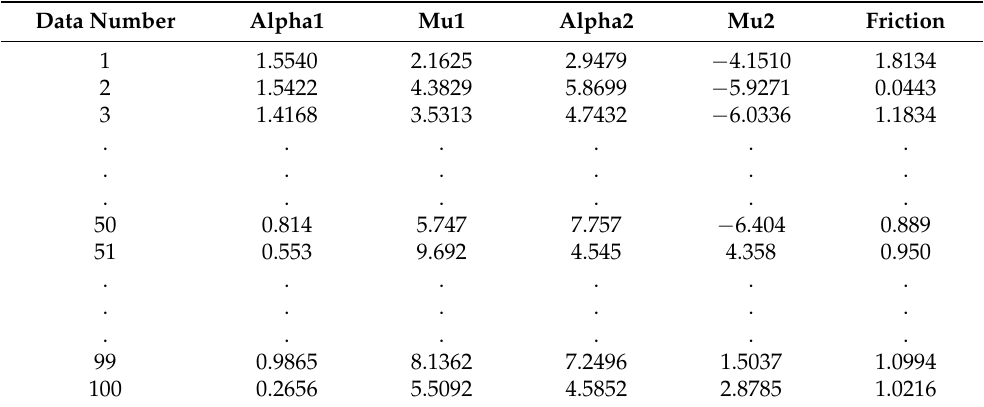
Table 1. Randomly generated material parameters.